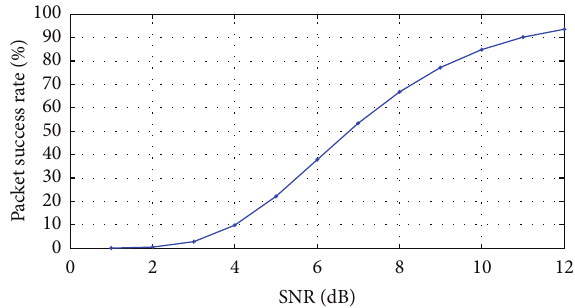
Figure 10: Analytical PRR with determining various regions of link